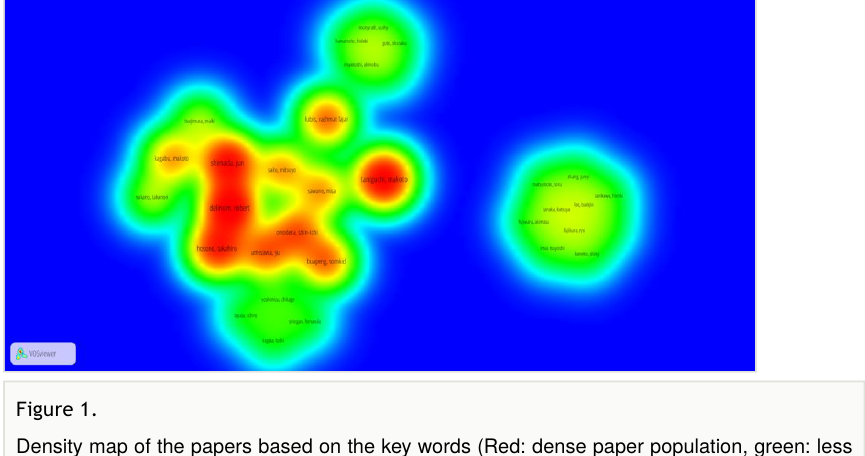
Density map of the papers based on the key words (Red: dense paper population, green: less dense). Dataset is available as Suppl. material 1 (in Irawan et al.